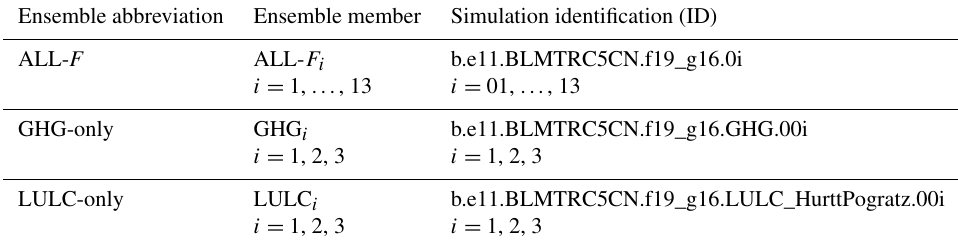
Table 3. CESM-LME simulations used in this study. The first and second columns present the abbreviations used in this paper for the ensembles and the ensemble members, respectively. The ID of the original experiment files is provided in the third